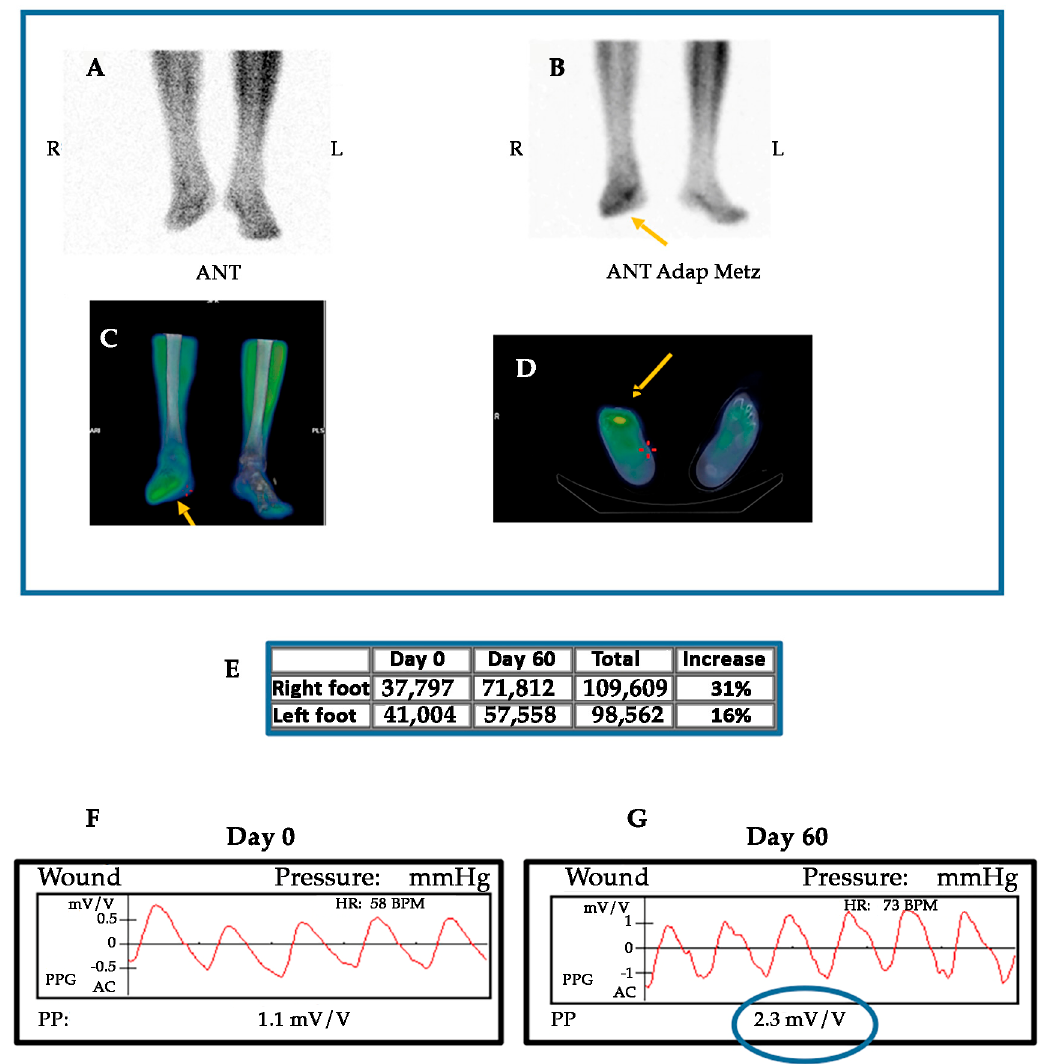
Figure 7. Combination of gammagraphy with leucocytes marked with technetium 99 m ( A , B ) and single photon emission computed tomography (SPECT)-MIBI ( C , D ), showing the increasing of flow in the right foot of a diabetic patient suffering from PAD (critical ischemia of the right limb). Before the treatment (( A ); Day 0), and after two months of GH treatment (( B – D ); Day 60). Arrows indicate the blood flow. The table shows the quantification of ROI (region of interest), demonstrating a final increase of flow of 31% of the right foot as compared with the same foot at day 0 ( E ). Photoplethysmography (PPG) from the same patient, showing the improvement in microcirculation at the wound level between the day 0 and ( F ) and the day 60 ( G ) after GH treatment. Blue circle depicts the increase in pulsatility (PP), measured in mV/V. HR: heart rate.